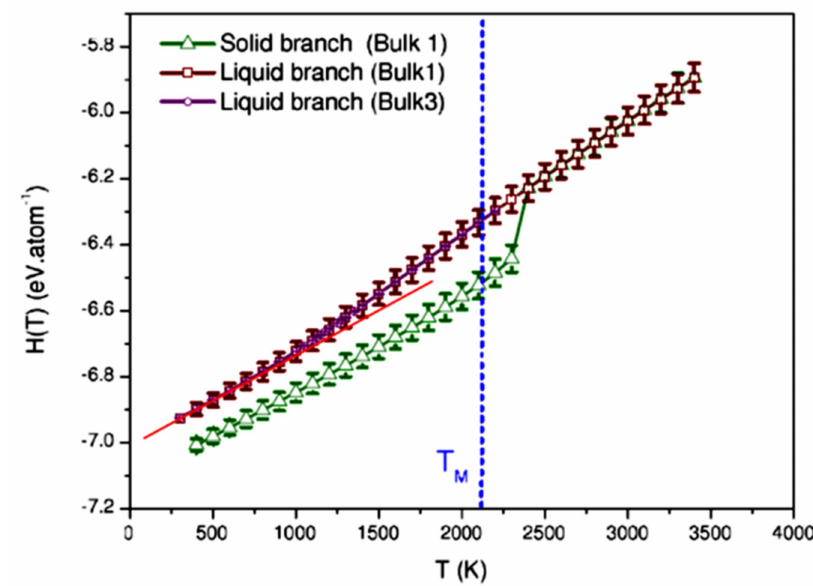
Figure 6. MD simulations of liquid zirconium enthalpy observing a melting temperature of 2378 K instead of T m = 2125 K. Reprinted with permission from [79]. Copyright American Physical Society